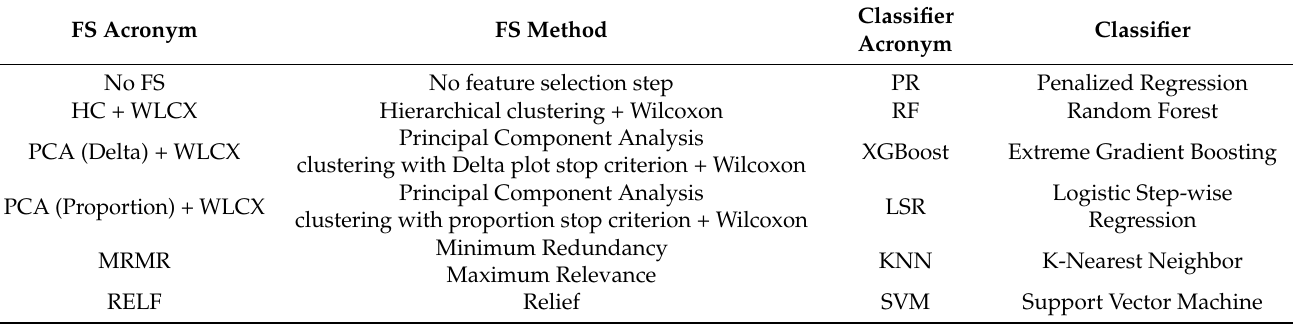
Table 2. List of applied feature selection methods (FS) and classifiers with acronyms used in the text. FS